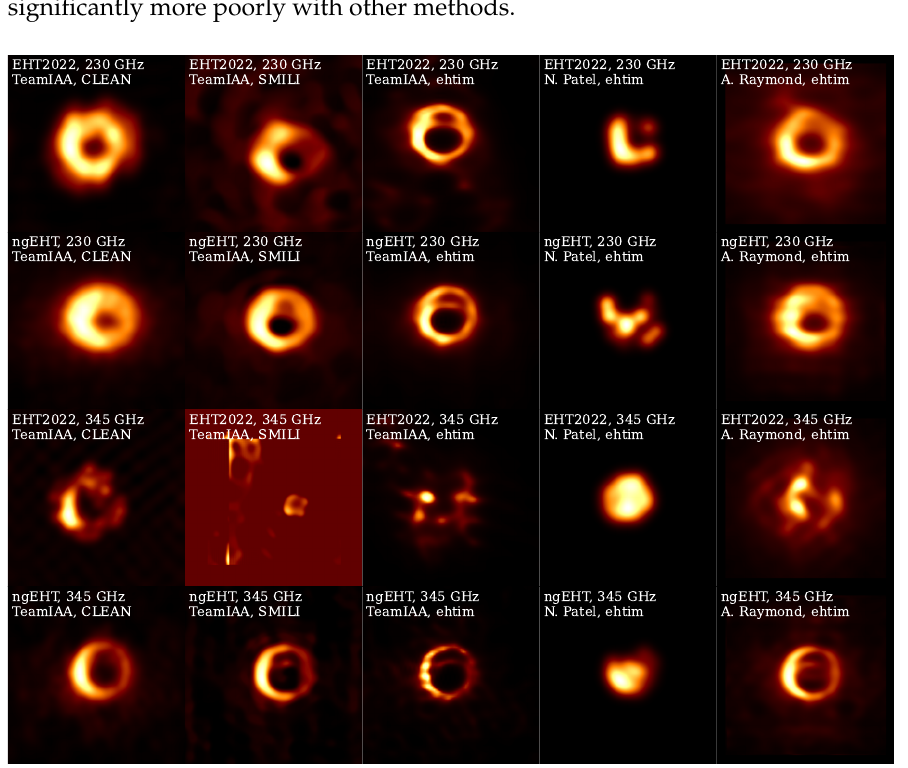
Figure 5. Sgr A* reconstructions submitted for Challenge 1. Images are shown on a linear scale with a 200 µ as field of